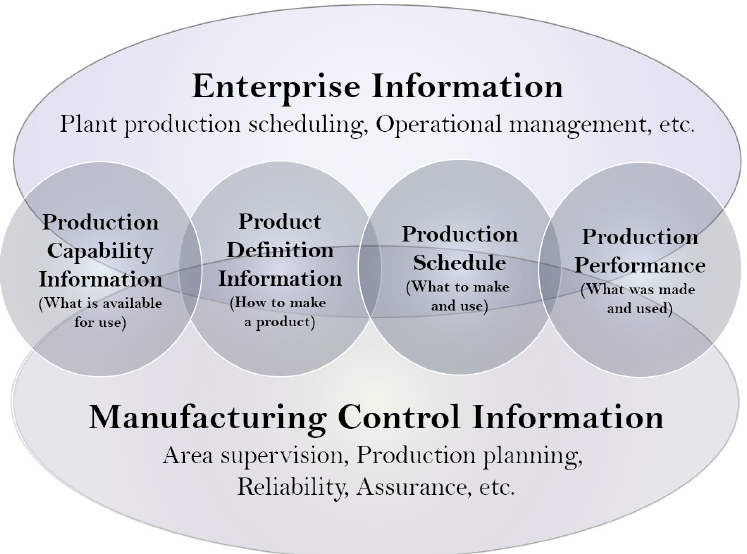
Figure 1. Instrumentation, Systems and Automation Society ISA-95 integration of information